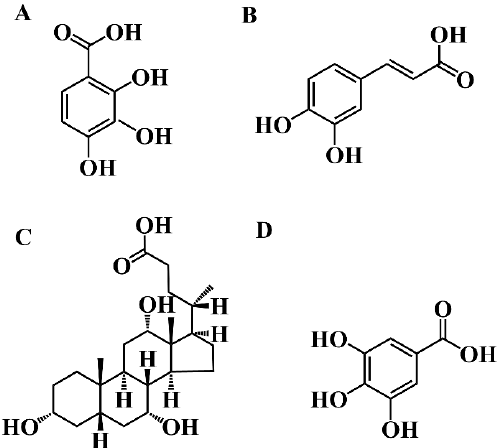
Figure 2. Chemical structures of ( A ) THB, ( B ) CFA, ( C ) CA and ( D ) GA. The chemical structures of GA, CFA, CA and THB contain anionic COOH groups.